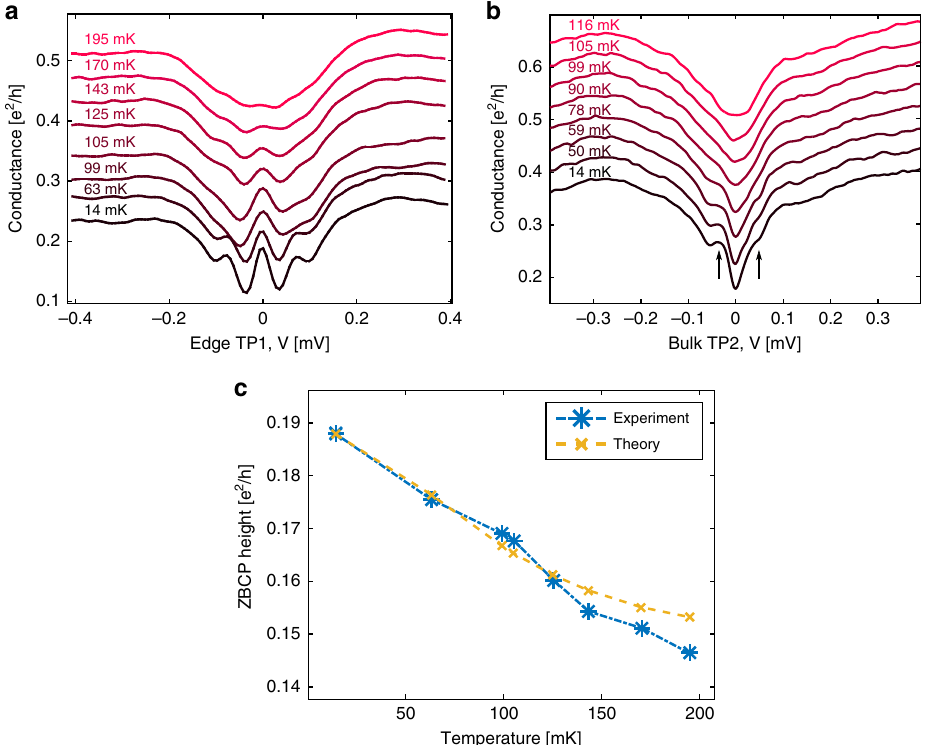
Fig. 4 Temperature dependence of the ZBCP and the bulk gap. a Dependence of the ZBCP on temperature (barely visible at T = ∼ 195 mK). b Dependence of the bulk gap on temperature. At T ∼ 99 mK, the superconducting gap shoulders disappear. Plots are shifted by 0.04 × e 2 / h for clarity. c The measured height of the ZBCP (blue) is plotted and is compared with a theoretical estimate (orange) — calculated by a convolution of the derivative of the Fermi distribution with the differential trace of the ZBCP at the base temperature (the temperature-independent broadening had been